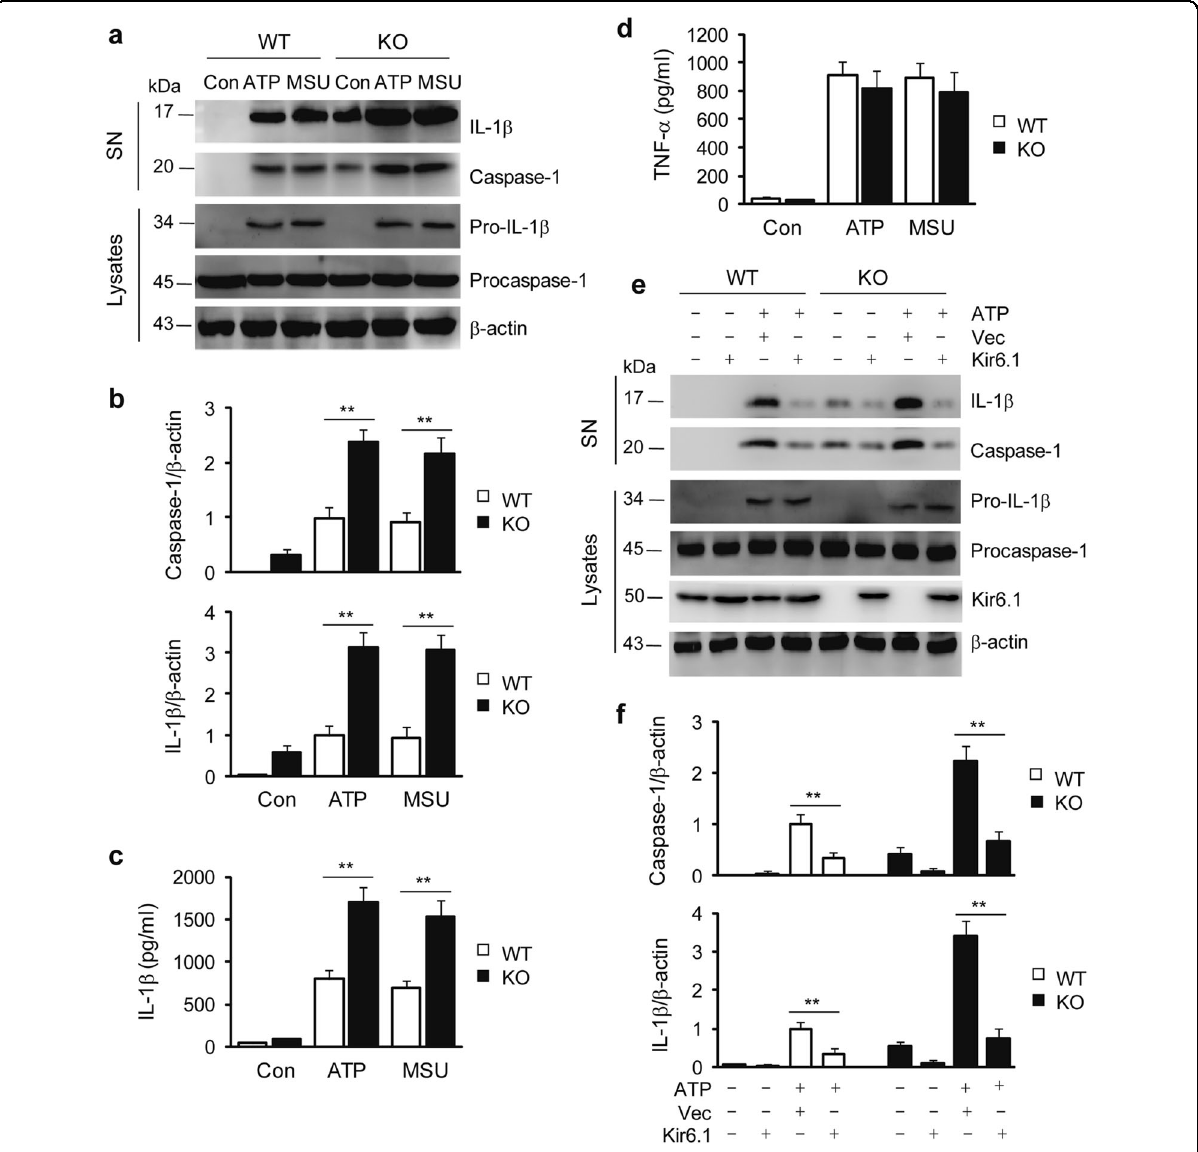
Fig. 2 Kir6.1 ablation activates the NLRP3 in fl ammasome in BMDMs. a Representative immunoblots showing NLRP3 in fl ammasome activation in response to stimulation with LPS plus ATP and MSU in MBDMs isolated from WT and Kir6.1 KO mice. The levels of caspase-1 and IL-1 β in the cell culture supernatants (SN) and procaspase-1 and pro-IL-1 β in the total cell lysates were measured by immunoblotting. b Quanti fi cation of caspase-1 (upper panel) and IL-1 β (lower panel), as shown in ( a ). c , d Concentrations of IL-1 β ( c ) and TNF- α ( d ) in BMDMs were measured by ELISA. The data shown are the mean ± SEM from four independent experiments. ** p < 0.01 vs WT. e Representative immunoblots showing the inhibition of NLRP3 in fl ammasome activation in BMDMs by transient expression of Kir6.1. BMDMs isolated from WT and Kir6.1 KO mice were transfected with Kir6.1 or control vector (Vec) for 48 h and then treated with LPS plus ATP. f Quanti fi cation of caspase-1 (upper panel) and IL-1 β (lower panel), as shown in ( e ). The data shown are the mean ± SEM from four independent experiments. ** p < 0.01 vs the cells transfected with control